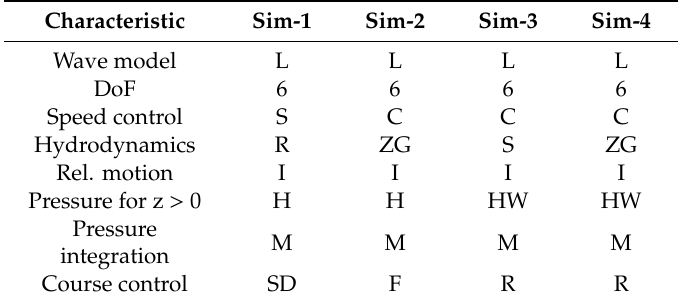
Table 2. Characteristics of the simulation programs (Sim 1–4) used in this